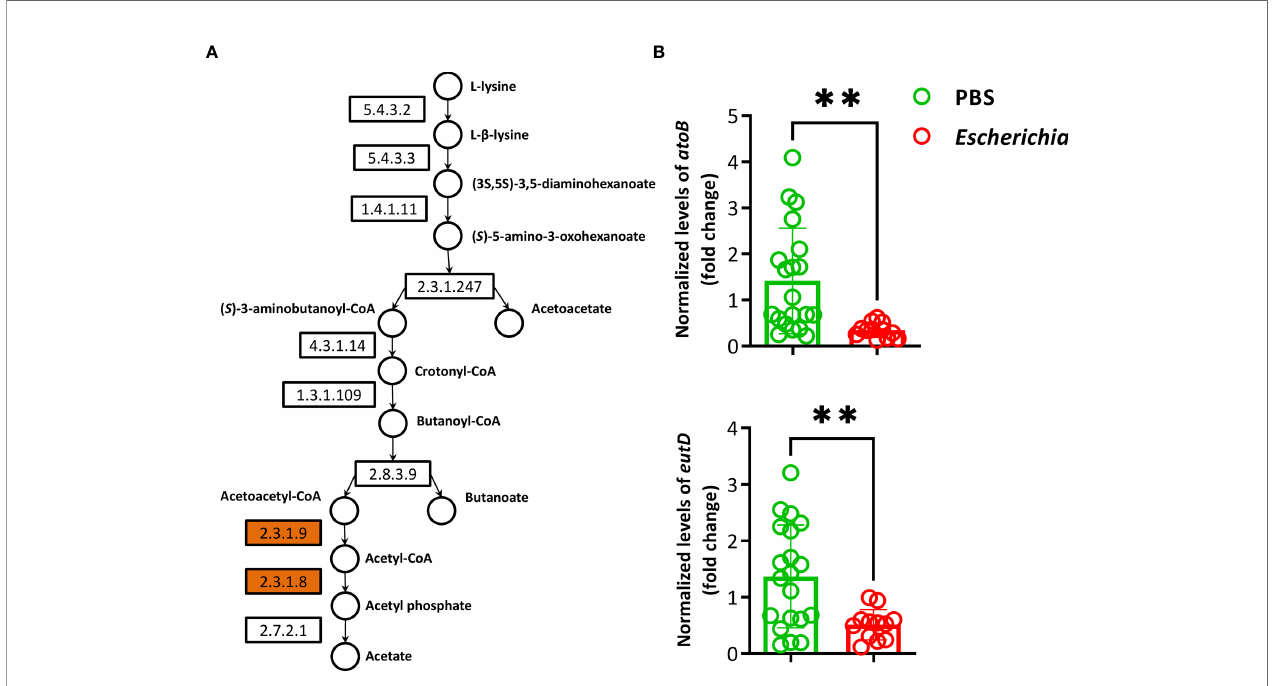
FIGURE 10 | Pathway P163-PWY and relative abundance of genes atoB and eutD . (A) The pathway P163-PWY was retrieved from MetaCyc database. The KEGG codes of the enzymes (boxes) and metabolites (close to the circles) involved in the pathway were added. Enzymes encoded by the genes atoB (EC.2.3.1.9) and eutD (EC.2.3.1.8) were highlighted (orange). (B) Normalized relative atoB (EC.2.3.1.9) and eutD (EC.2.3.1.8) levels were measured by qPCR in DNA samples of ticks fed on E. coli -immunized mice using gene-speci fi c primers and normalizing against tick rsp4 with the 2 − DD Ct ratio method. Results are relative to atoB and eutD in the control group (PBS). Individual technical replicates, means and standard deviation values are displayed. Results were compared by Mann − Whitney U test. (** p < 0.001; n = 6 DNA samples of ticks fed on E. coli -immunized mice, n = 10 DNA samples of the control group, two technical replicates per